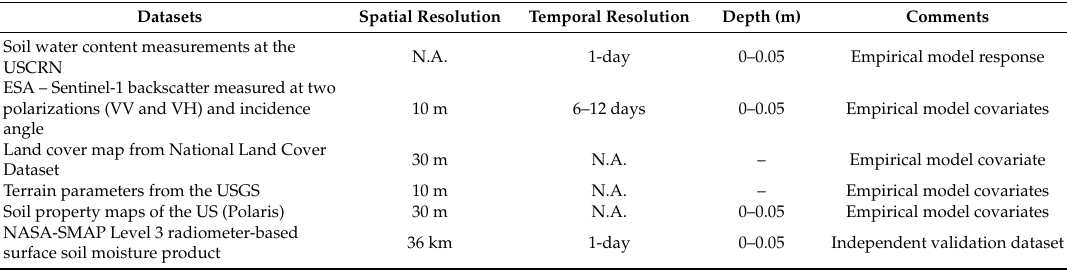
Table 1. Remote sensing and environmental covariates used to retrieve soil moisture across the